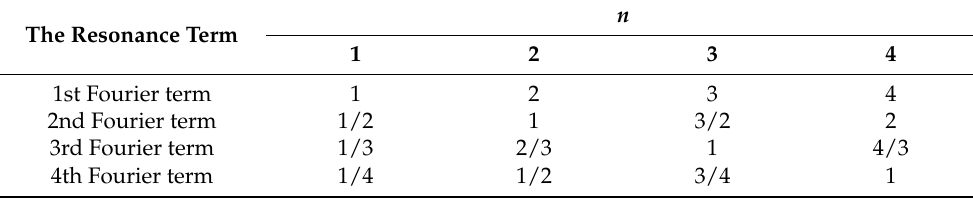
Table 4. Based on the resonance